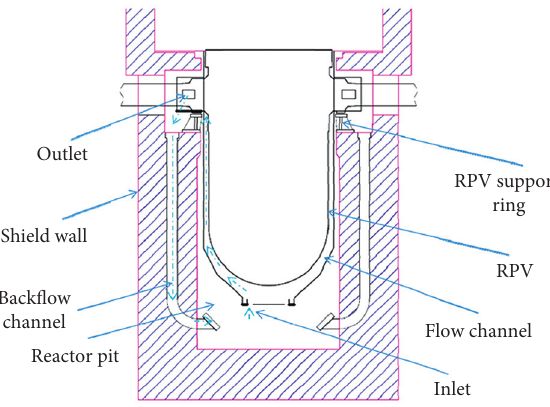
Figure 2: The natural circulation in the reactor